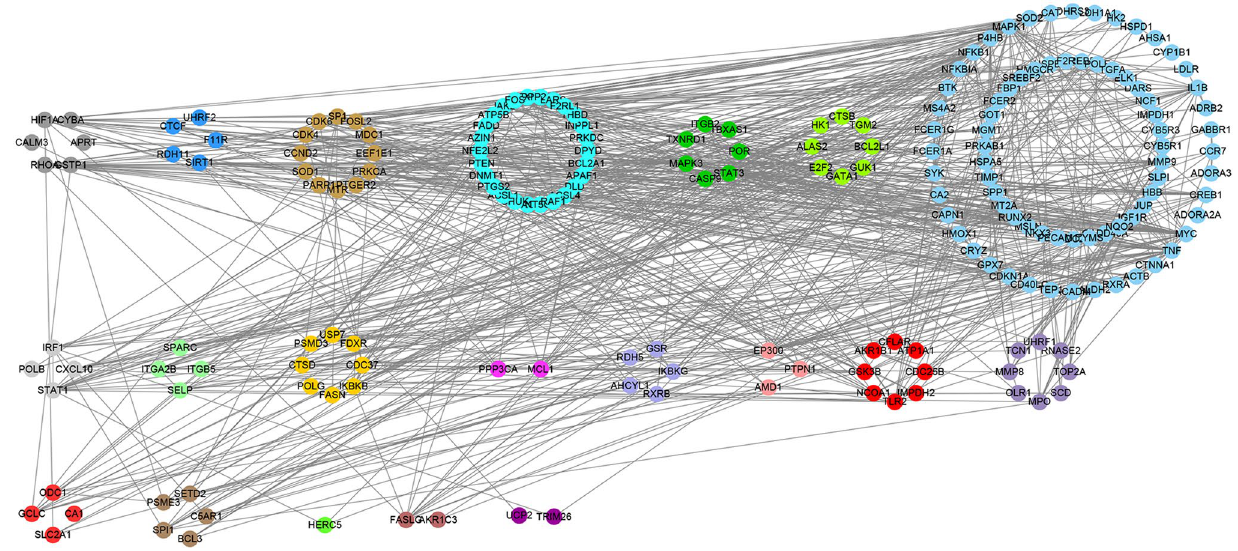
Figure 3. Constructing network based on Cytoscape 3.7.0. (https:// cytos cape. org/). Module diagram of MI weighted gene co-expression network mapped to Yixinyin PPI network. The different colors in the figure represent the corresponding modules. The black line represents the PPI relationship between the